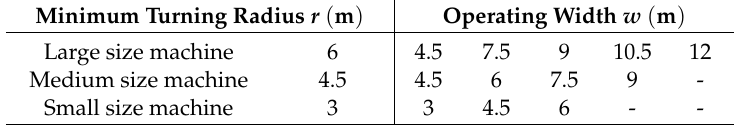
Table 1. Tested setups of machinery and implements.